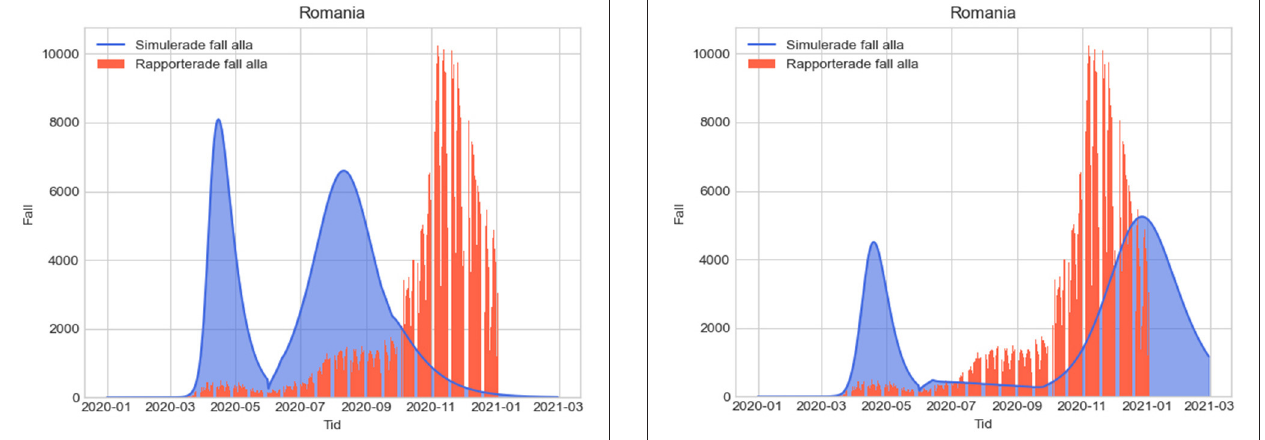
FIGURE 3 | L3: Epidemiologic evolution with social distancing recommended. Total unreported cases 2020-2021: 12,930,507.92; total unreported cases